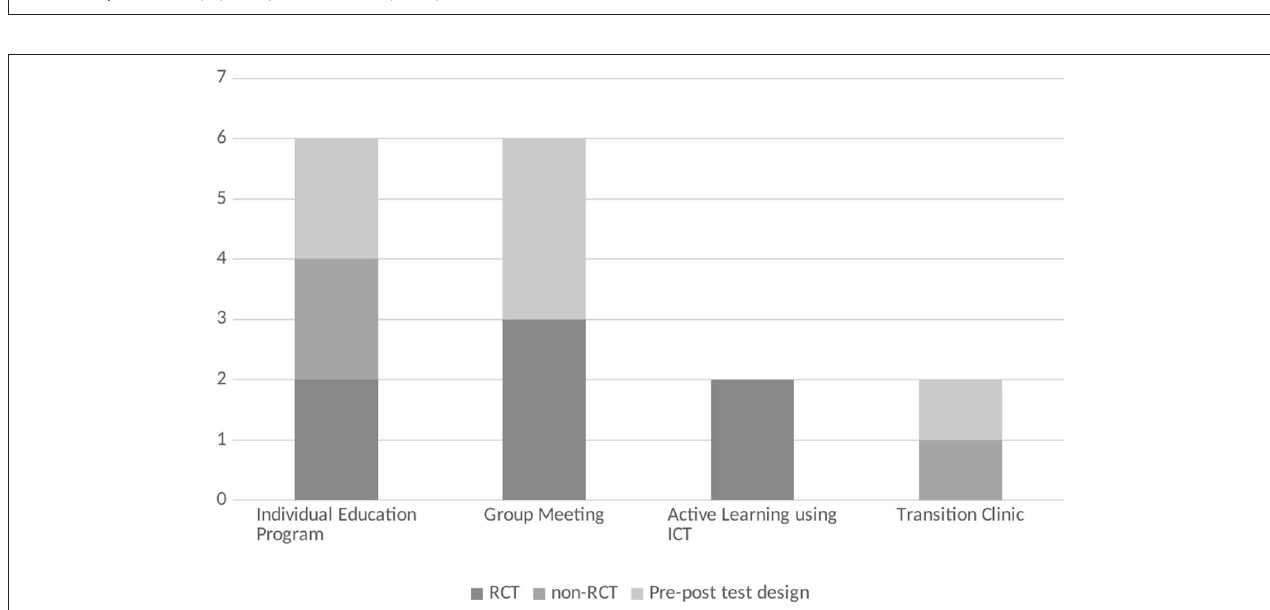
FIGURE 3 | Number of papers by disease of the participant.